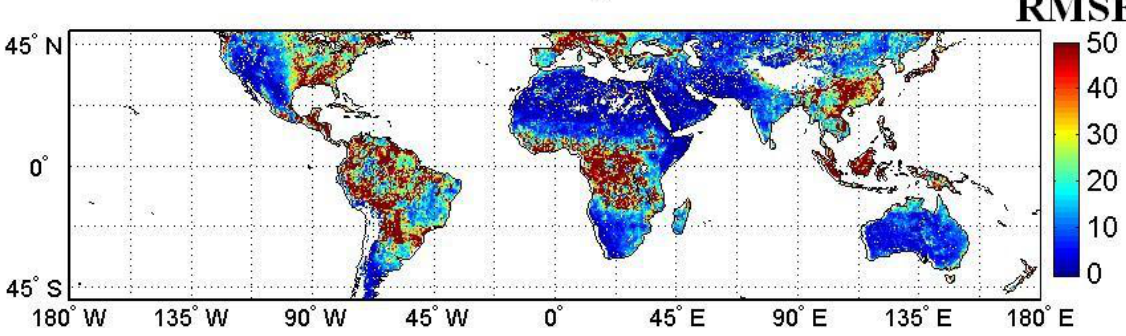
Fig. 5. Example of the TC method for the AMSR-E descending overpass, the analysis period was January 2007 till September 2010. Blue areas indicate low TC outputs and red areas indicate high TC outputs.